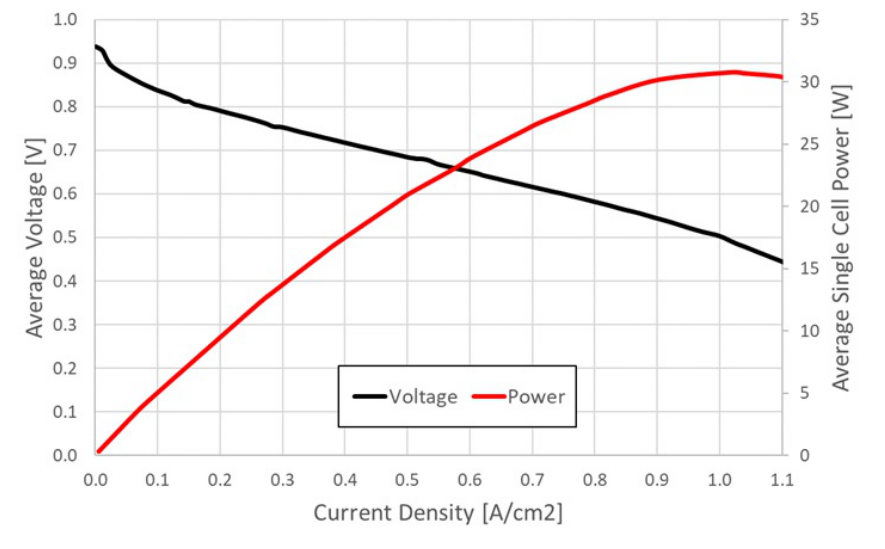
Figure 10. Polarization (black) and Power (red) curves vs current